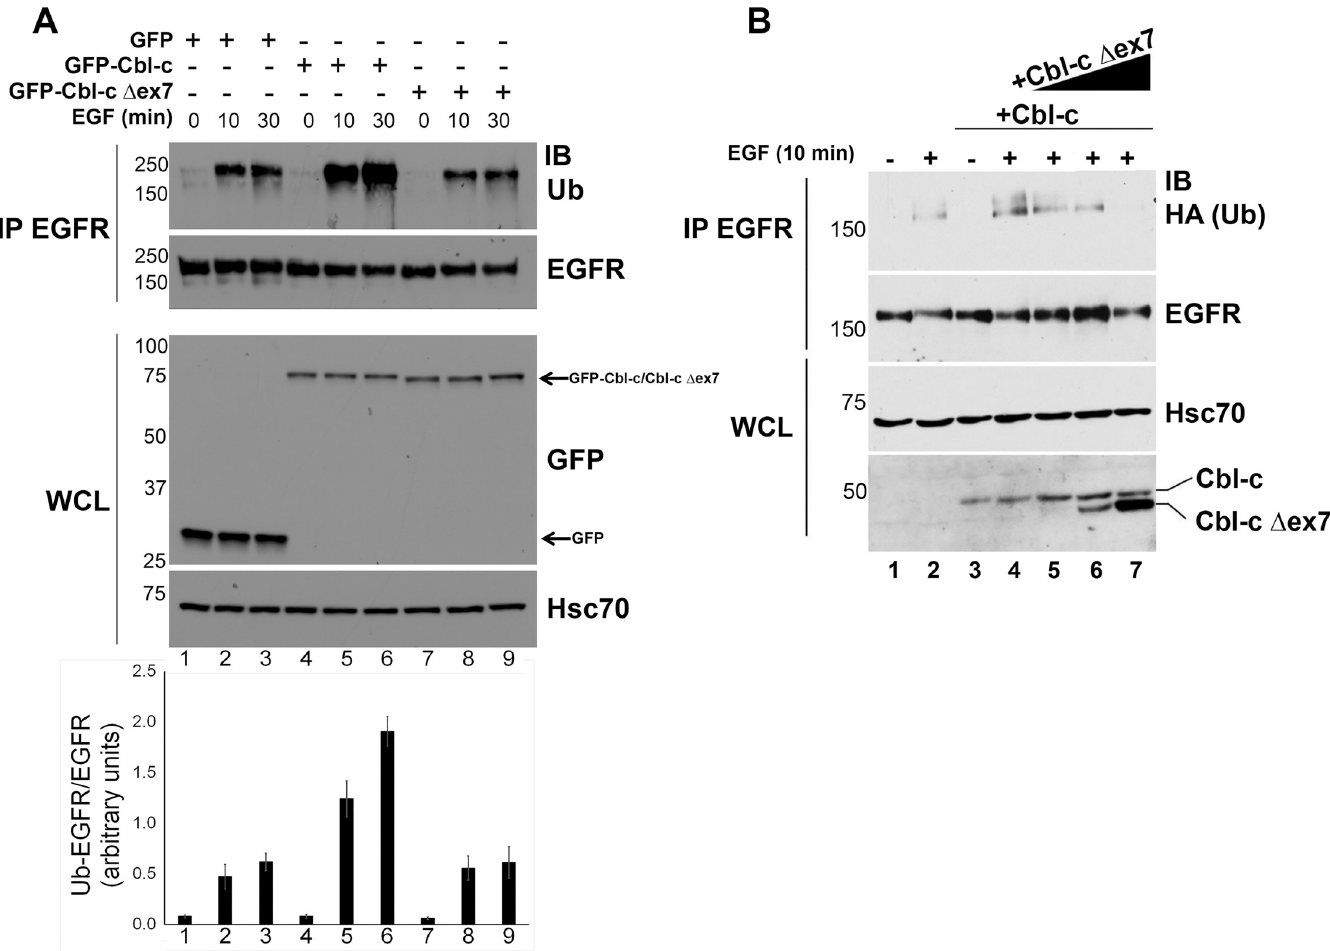
Fig 3. Loss of E3 function in a mouse ductal carcinoma Cbl-c mutant. ( A ) Cbl-c Δ ex7 lacks E3 activity. HEK 293T cells were transfected with plasmid encoding wild- type and mutant mouse GFP-tagged Cbl-c along with human EGFR. Triplicate plates were pooled and split at 24 h post-transfection. At 48 h post-transfection, triplicate plates were treated with 100 ng/mL EGF for 10 or 30 min prior to cell harvesting. EGFR immunoprecipitations were immunoblotted for endogenous Ub to visualize EGFR ubiquitination. The immunoblots were quantified by image analysis and the intensity of the ubiquitinated EGFR/total EGFR is shown in the graph below the immunoblot. The graph represents the average relative ubiquitination/EGFR+/- SE for 5 experiments. (B) Cbl-c Δ ex7 acts to prevent ubiquitination of the activated EGFR by wild type Cbl-c. HEK 293T cells were transfected with plasmid encoding wild-type and mutant mouse Cbl-c along with human EGFR and HA-tagged ubiquitin as indicated. Duplicate plates were pooled and split at 24 h post-transfection. At 48 h post-transfection, duplicate plates were treated with EGF (or water as a vehicle control) for 10 min prior to cell harvesting. EGFR immunoprecipitations were immunoblotted for HA to visualize EGFR ubiquitination. Whole cell lysates were immunoblotted and probed for mouse Cbl-c with either anti-GFP or anti-Cbl-c antibodies and human Hsc70 which served as a lysate loading control. Molecular weight standards in kDa are indicated on the left of each panel.